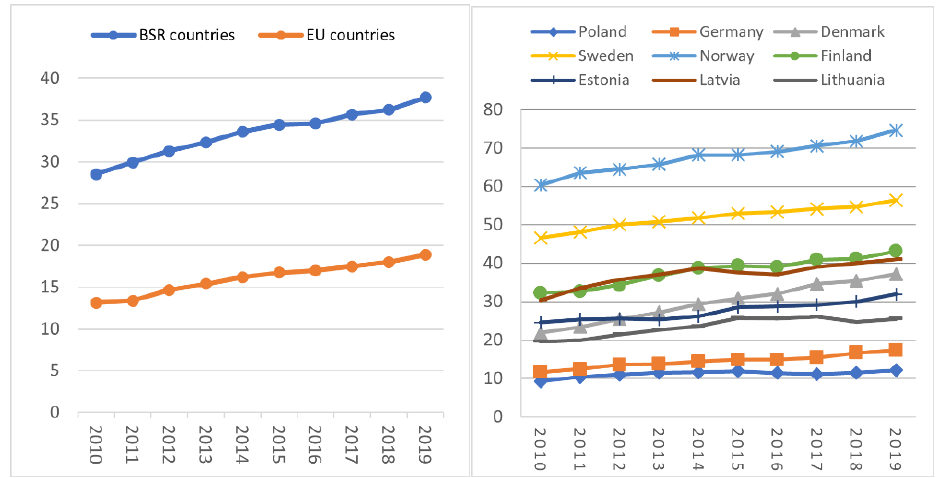
Figure 5. The share of renewable energy in total energy generation in EU, BSR, and particular BSR states (2010 – 2019) [%]. Source: own study based on [43].